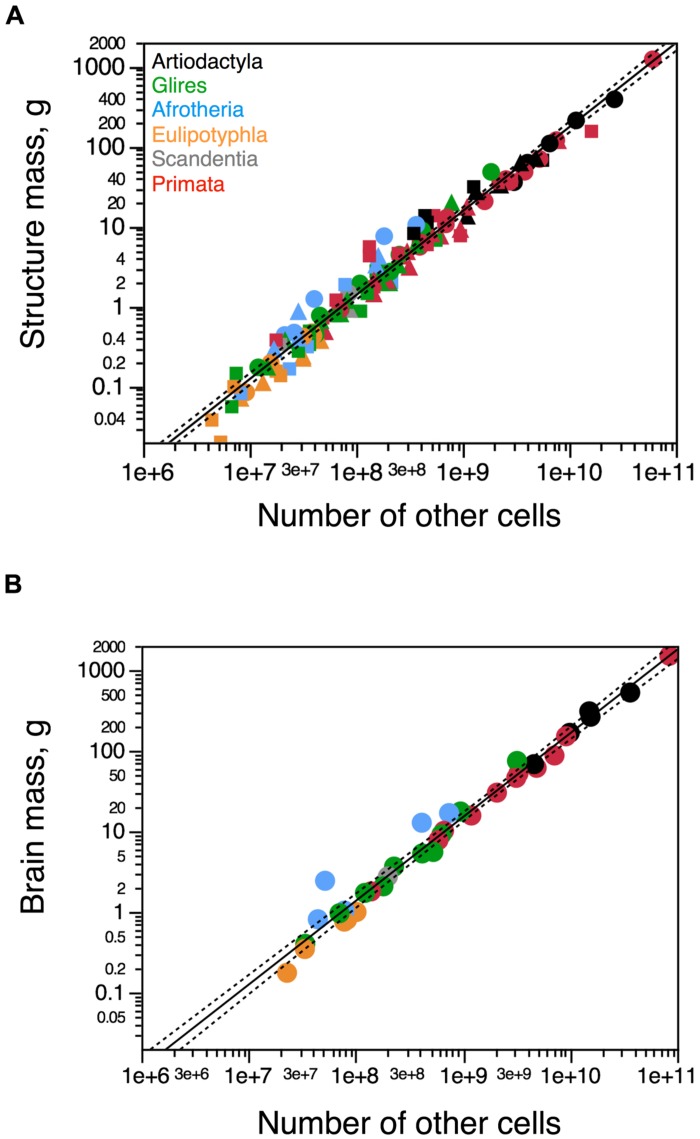
Artiodactyls fit the non-neuronal scaling rules for all brain structures and mammalian clades. Plots show the relationship between structure mass and number of non-neuronal (other) cells for (A) each brain structure or (B) the brain as a whole. Circles, cerebral cortex (A) or whole brain (B); squares, cerebellum; triangles, rest of brain. Functions plotted apply to the ensemble of species, including artiodactyls. Exponents are 1.035 ± 0.017 (A) and 1.020 ± 0.026 (B). Artiodactyl species in black, primates in red, glires in green, afrotherians in blue, insectivores in orange, scandentia in gray. Data from Herculano-Houzel et al. (2006, 2007, 2011), Azevedo et al. (2009), Sarko et al. (2009), Gabi et al. (2010), and Neves et al. (2014).